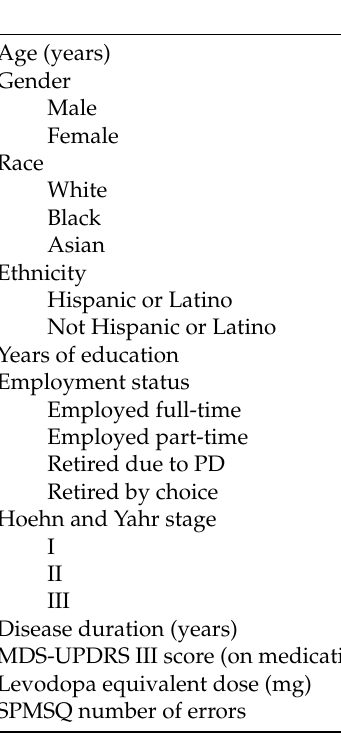
Table 2. Participant demographics and baseline